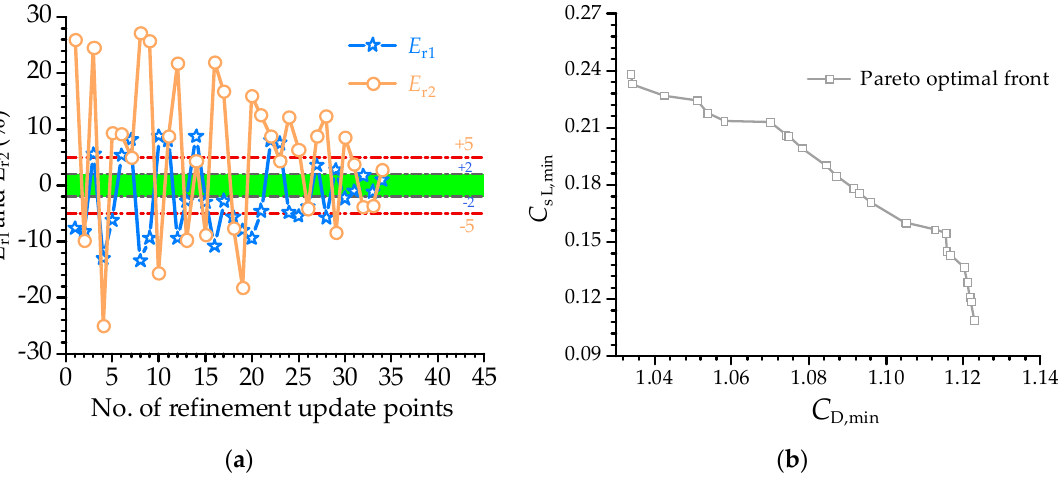
Figure 7. ( a ) Updating process of the relative errors of the aerodynamic force coefficients and ( b ) Pareto-optimal set of the aerodynamic force coefficients.